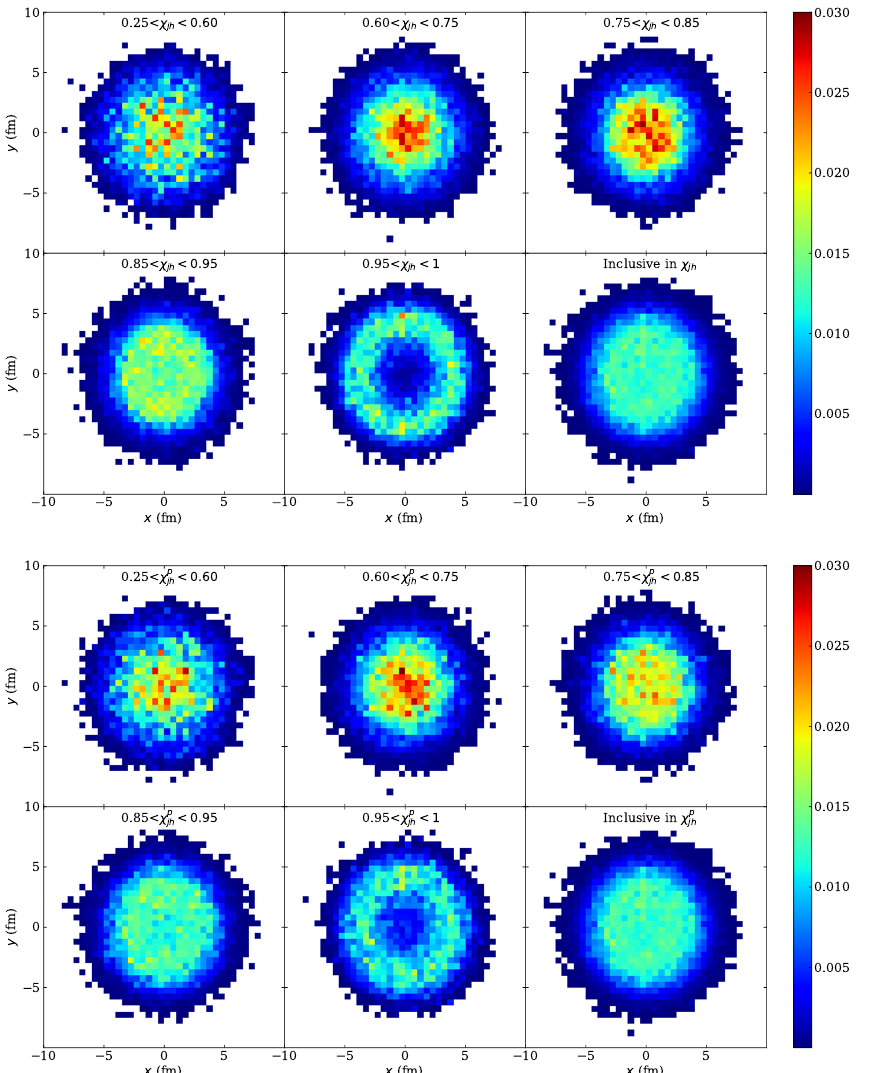
Figure 19 . Creation point distributions in the transverse plane for different ranges of the true value χ (top panel) as well as the predicted value χ p jh